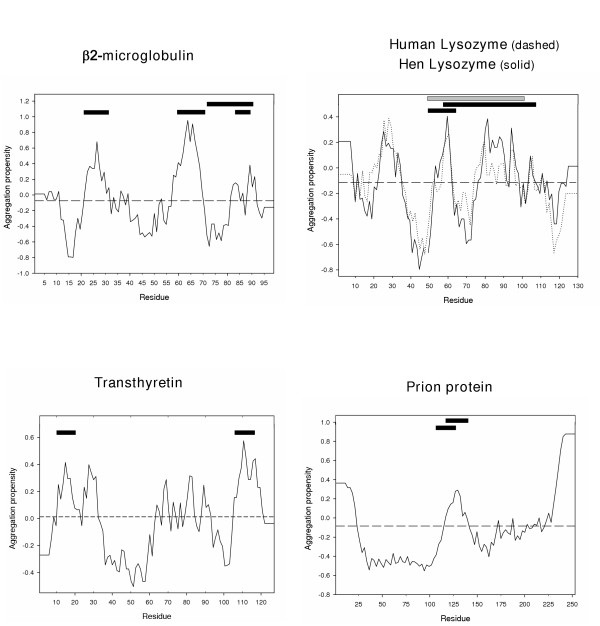
Aggregation profile of globular proteins related to disease. Minimal protein regions which have been proved experimentally to be involved in aggregation are shown at the top of the plot as black bars. Regions in the core of the fibrils are shown as a grey bars (when information available).